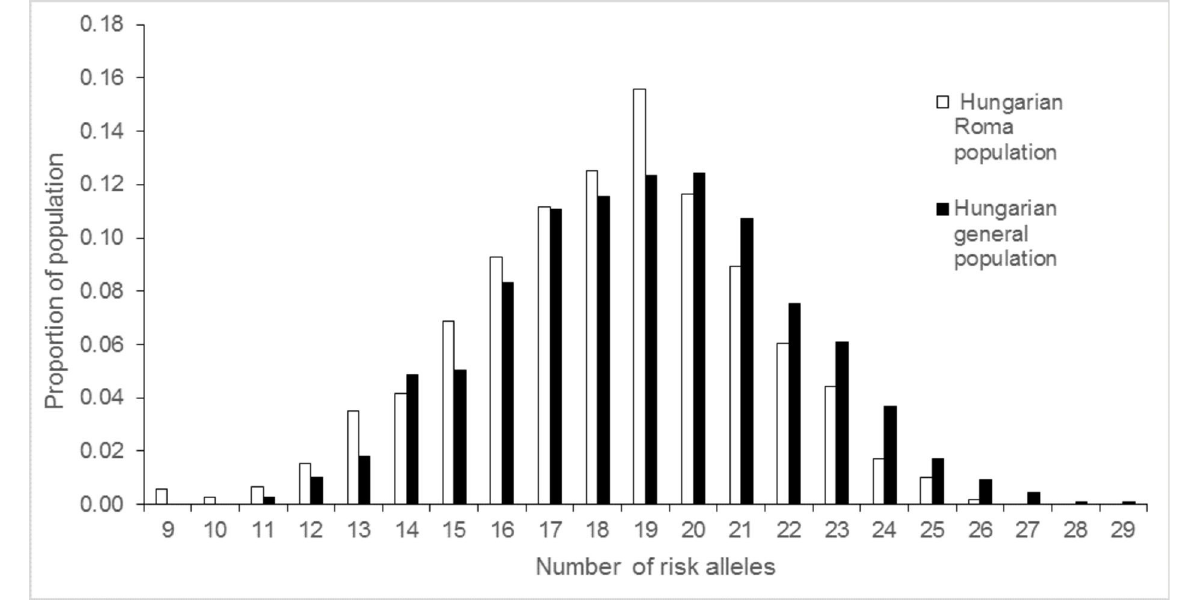
Fig 2. The distributions of GRSs in the HG (black) and HR (white) populations were significantly different (p < 0.001). https://doi.org/10.1371/journal.pone.0234547.g002 HG population, while non-normally distributed for the HR population. The mean of the gene count score was 18.25 ± SD 2.97 in the HR group and 18.98 ± SD 3.05 in the HG group. The study groups were different by GRS distribution according to the Mann-Whitney U test (p < 0.001, Fig 2). The multivariate linear regression analysis performed on the GRSs confirmed the associa- tion between genetic risk and ethnicity independently of the effect of age, gender and BMI (p < 0.001, Table 3, part A). Table 3. The multivariate linear regression analysis performed on GRSs to confirm the association between genetic risk and ethnicity. A) dependent variable: GRS R Square = 0.0167 Independent variables Coefficient p value β ethnicity (General vs. Roma) -0.742 < 0.001 -0.122 gender (men vs. women) -0.201 0.119 -0.033 age -0.001 0.857 -0.004 BMI -0.010 0.365 -0.020 B) dependent variable: wGRS R Square = 0.0085 Independent variables Coefficient p value β ethnicity (General vs. Roma) -0.125 < 0.001 -0.080 gender (men vs. women) -0.050 0.135 -0.032 age -0.0001 -0.002 BMI -0.004 0.150 -0.032 β : relative strength of